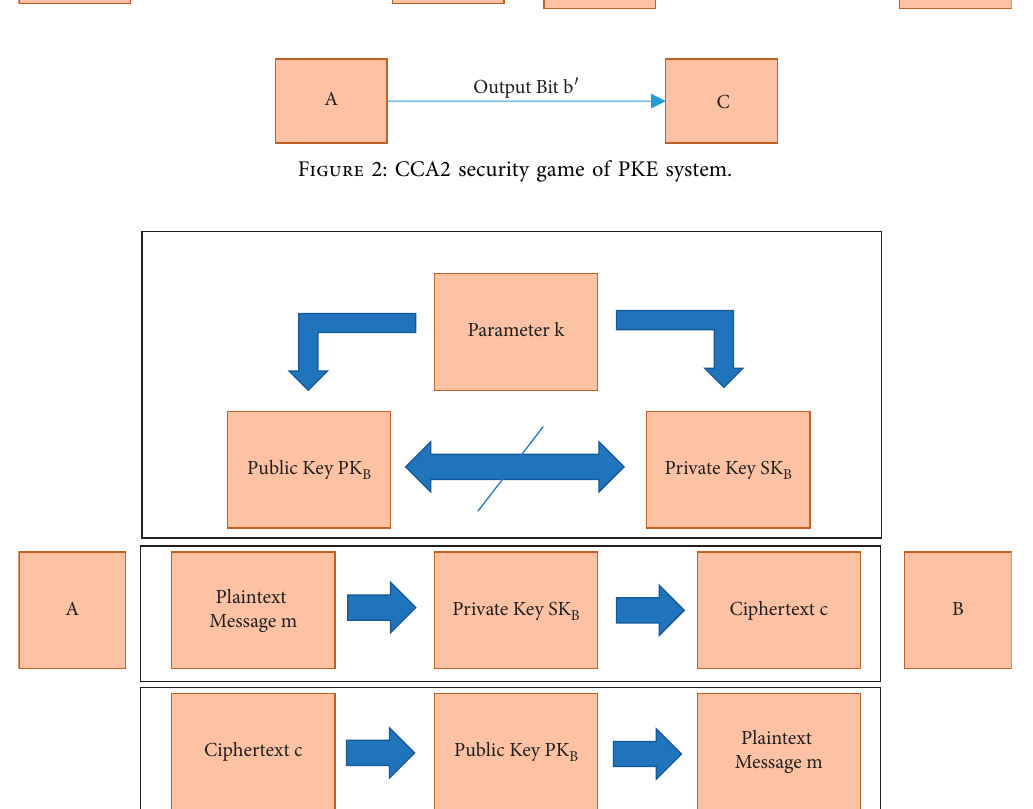
Figure 3: Digital signature communication